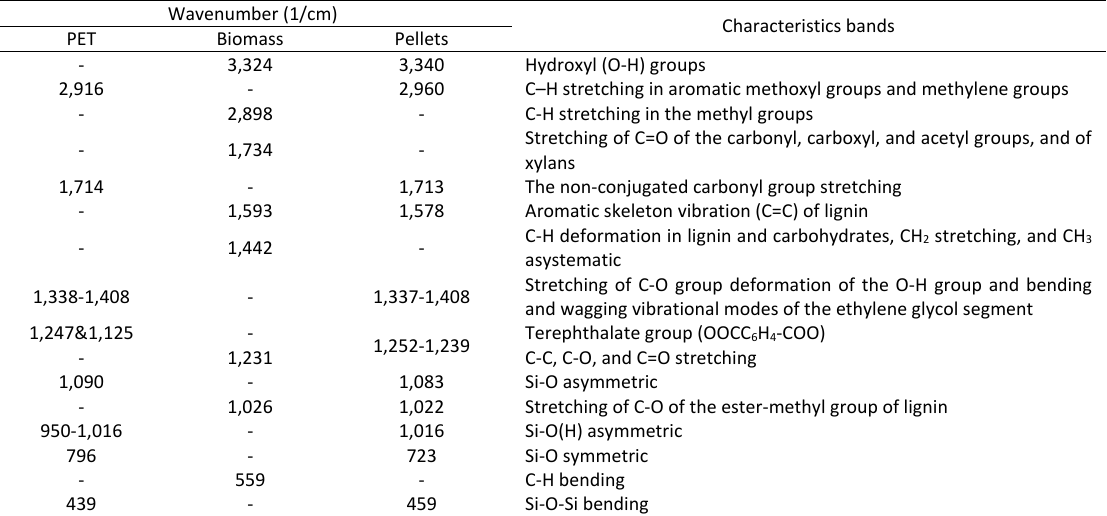
Table 2: Characteristics bands of the PET waste, biomass, and pellets obtained by FTIR Wavenumber (1/cm)